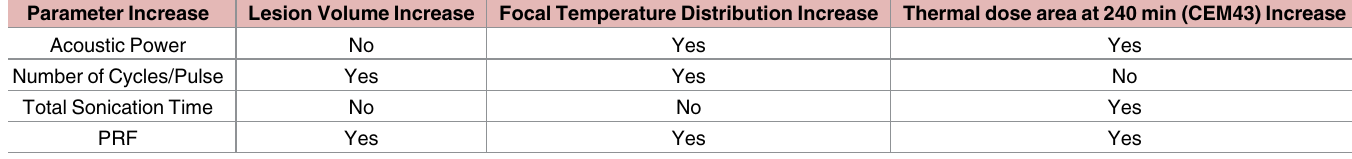
Table 3. Effect of each of the four BH sonication parameters on significant increasein lesion volume and focal region temperature are summa- rized. Increasingacoustic power did not result in an increasein lesion volume, whereastemperature distributionand area of lethal thermal dose increased. While increasing number of cycles/pulse, both lesion volume and temperature distributionincreased. No increase in either lesionvolume or temperature distri- bution was observedwhile increasing total sonicationtime, but area of lethal thermal dose increased. Varying pulse repetitionfrequencyresulted in increased lesion volume and temperature distributionand area of lethal thermal